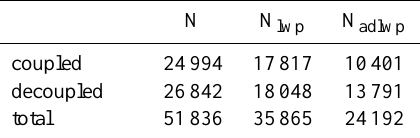
Table 3. Number of 1 Hz samples contributing to the distributions shown in Fig. 13. These represent all samples from thirteen research flights with well-defined cloud bases and LCLs.